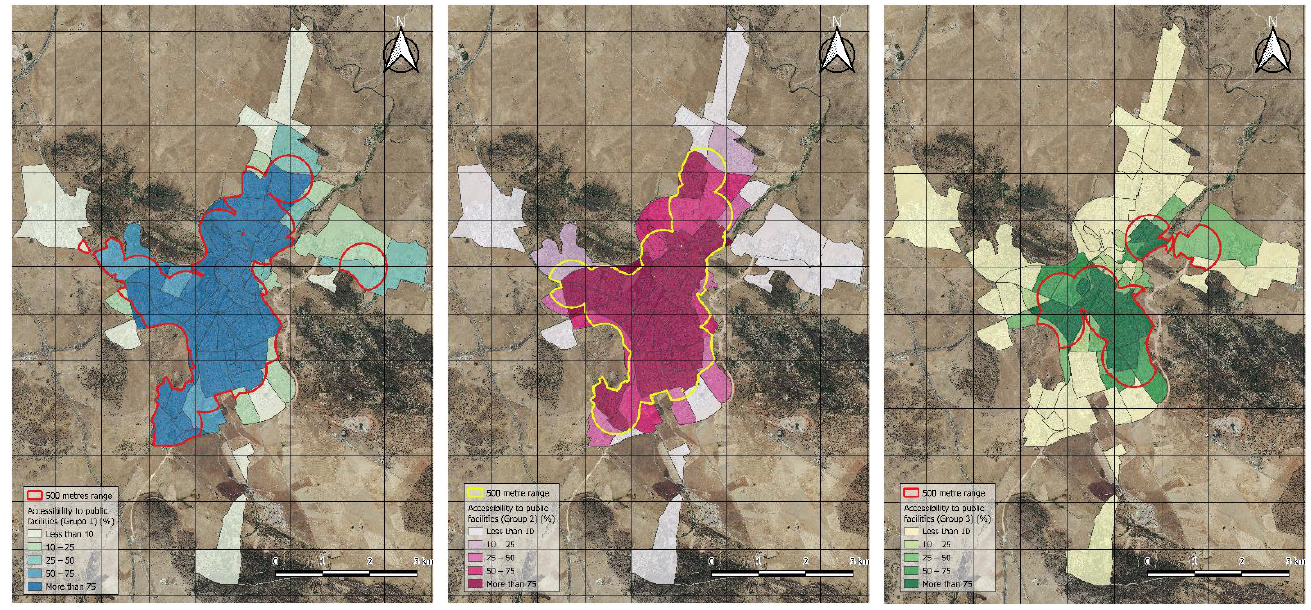
Figure 8. Degree of accessibility to public facilities.